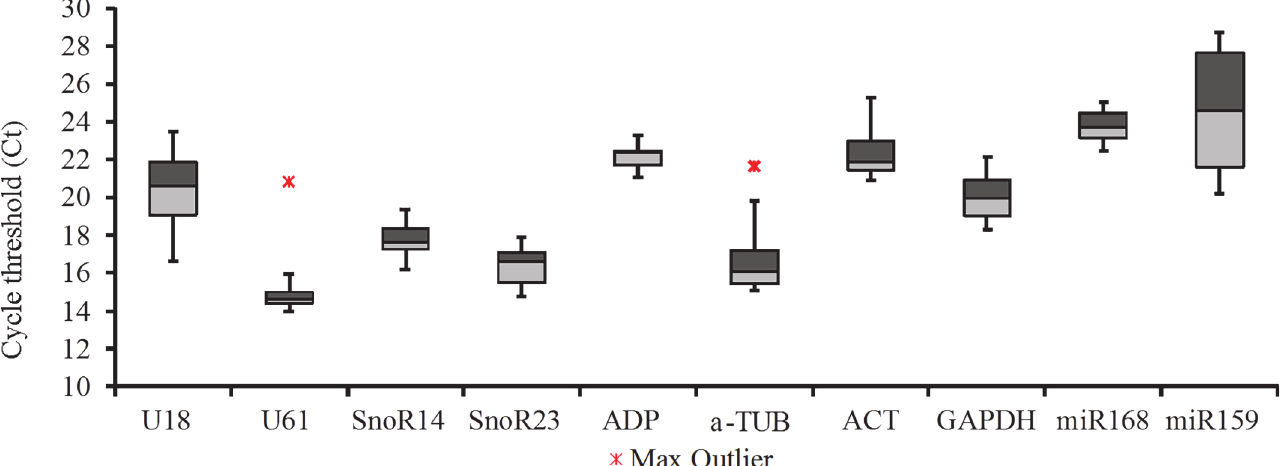
Fig 2. Gene expression of ten candidate internal controls in all samples. Data points are cycle threshold (Ct) values for each candidate reference gene in all samples. Boxes indicate the 25 th (light shading) and 75 th (dark shading) percentiles, the line indicates the median and whiskers depict the maximum and minimum